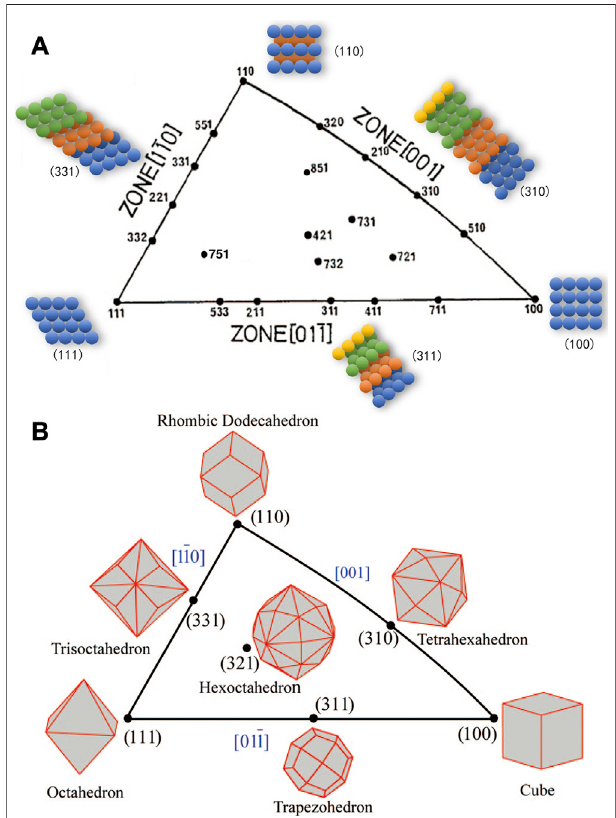
FIGURE 2 | The unit stereographic triangle of fcc single crystal. (A) Crystallographic facets illustration and crystallographic facets diagram of fcc single crystal. (B) Schematic diagram of single crystal surrounded by some crystallographic facets. (B) Reproduced with permission (Tian et al., 2008). Copyright 2008, American Chemical